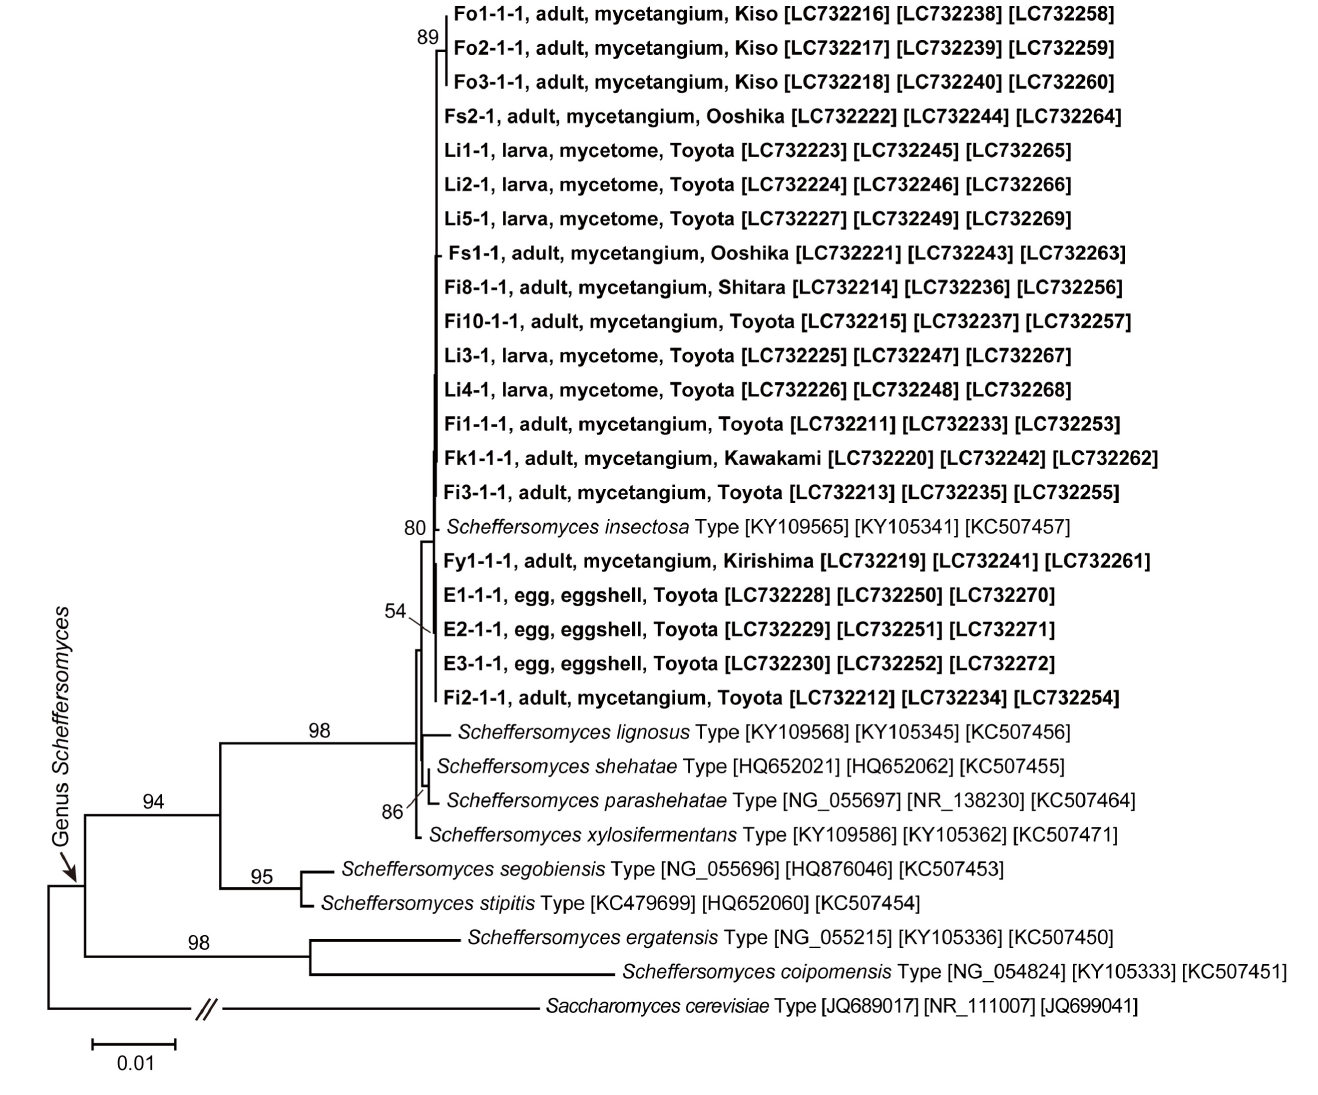
Fig 4. Phylogenetic placement of yeasts constantly-isolated from Leptura ochraceofasciata . A neighbor-joining phylogenetic tree was constructed using the DNA sequences of 26S (570 bps), ITS/5.8S (618 bps), and TEF (584 bps) genes. Bootstrap values (1000 replicates) of 50% or higher are shown at the nodes. For each yeast strain obtained from L . ochraceofasciata in this study, the name of the strain, developmental stage and isolation source of the host insect, and collection locality are indicated in bold. Sequence accession numbers are shown in brackets.